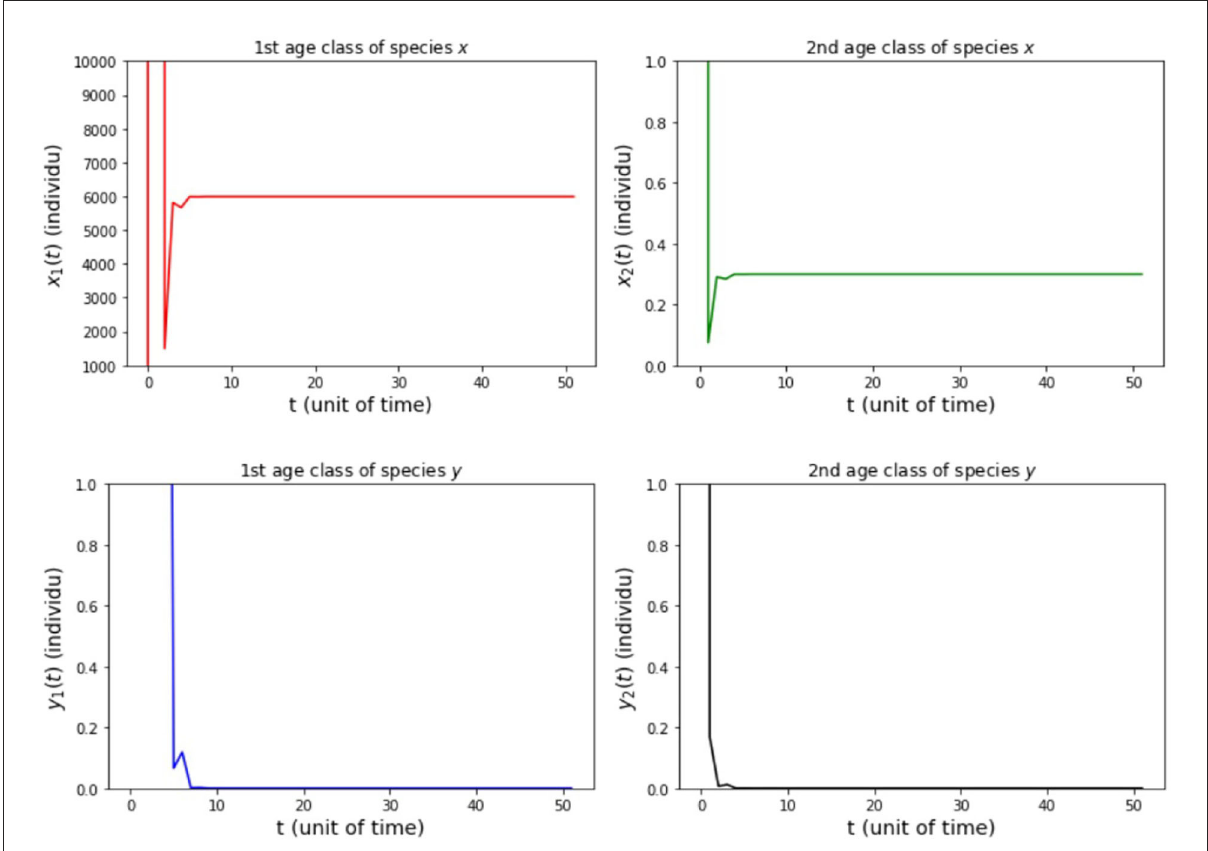
FIGURE3 Population growth of each age class from case (ii) Model